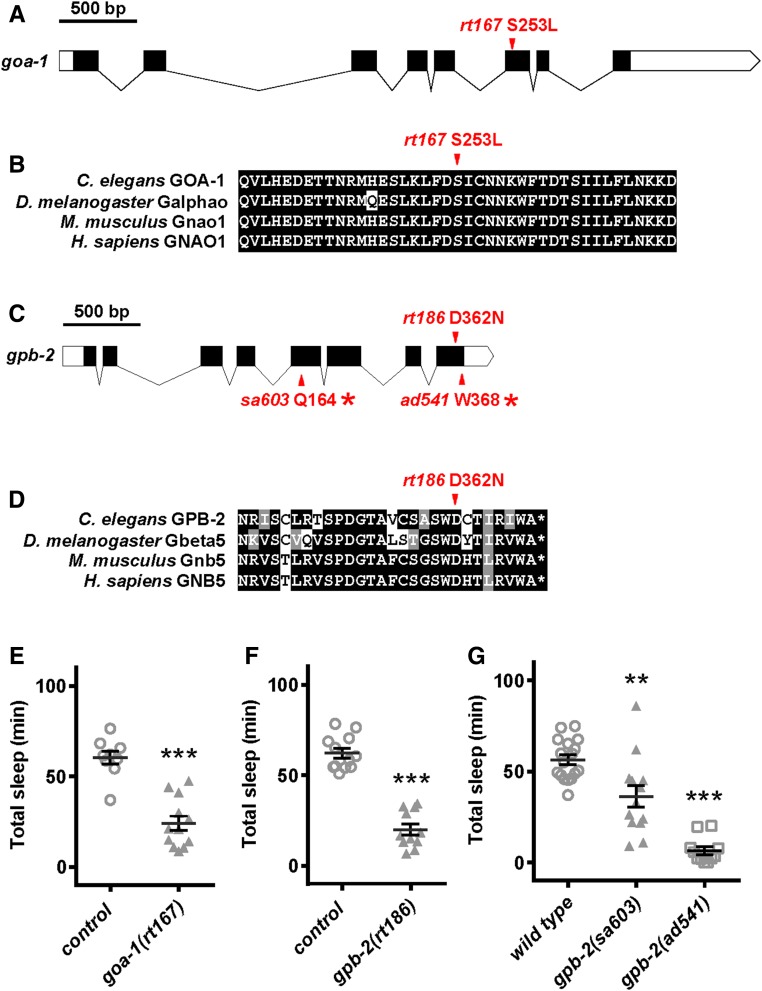
Identification of goa-1 and gpb-2 alleles. (A) Diagram showing location of goa-1(rt167) in the sixth exon of goa-1. (B) Alignment of amino acids adjacent to goa-1(rt167) showing cross-species conservation. (C) Diagram showing location of gpb-2(rt186) in the last exon of gpb-2, as well as preexisting loss-of-function alleles that were examined herein. (D) Alignment of amino acids adjacent to gpb-2(rt186) showing cross-species conservation. (E) goa-1(rt167) animals had reduced total sleep compared to control hsp::osm-11 animals. None of these animals were heat shocked. Results from 2× backcrossed animals shown. (F) gpb-2(rt186) animals had reduced total sleep compared with control hsp::osm-11 animals. None of these animals were heat shocked. Results from 2× backcrossed animals shown. (G) Animals carrying preexisting gpb-2 alleles had decreased total sleep, compared with wild-type animals. Mean and SEM indicated, along with results for individual animals for each genotype. ** P < 0.01, *** P < 0.001 by Student’s t-test vs. control or wild-type animals run in parallel in multiple trials.